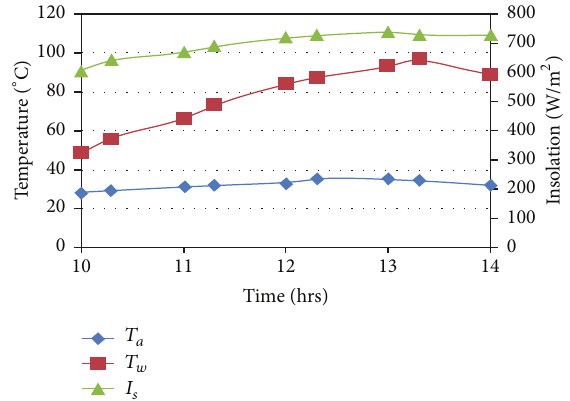
Figure 3: Water heat up test of solar cooker for second figure of merit ( 𝐹 2 )